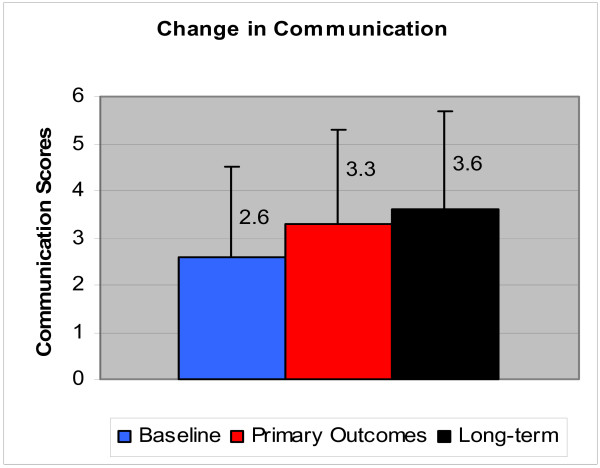
Changes in Communication. • Baseline to Long-term Outcomes P-value < 0.001 (determined by Wilcoxon). • Primary Outcomes to Long-term Outcomes P-value = 0.007 (determined by Wilcoxon).